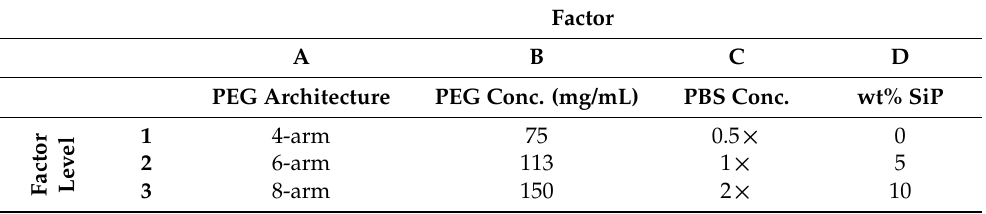
Table 1. Factor and factor levels utilized for the robust design experiment.